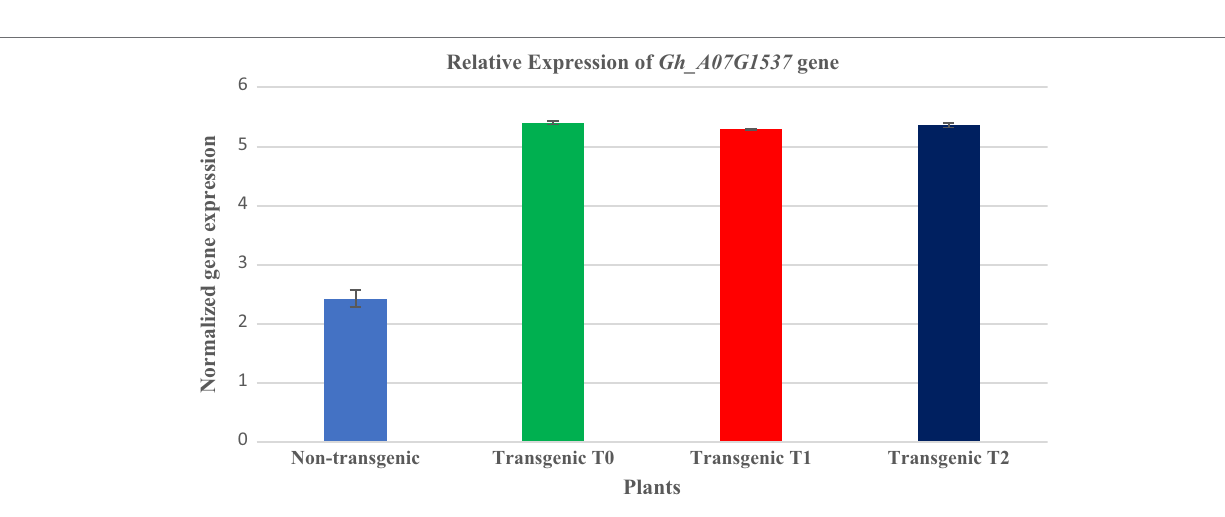
FIGURE 9 | Comparative expression analysis of transgenic (T0, T1, and T2) and non-transgenic cotton plants three each through Realtime qRT-PCR. Expression of the transgene was higher in all three generations of transgenic cotton plants as compared with that in the non-transgenic plants. Blue color shows non-transgenic: green, red, and royal color show relative expression of the transgene in T0, T1, and T2 transgenic cotton plants,